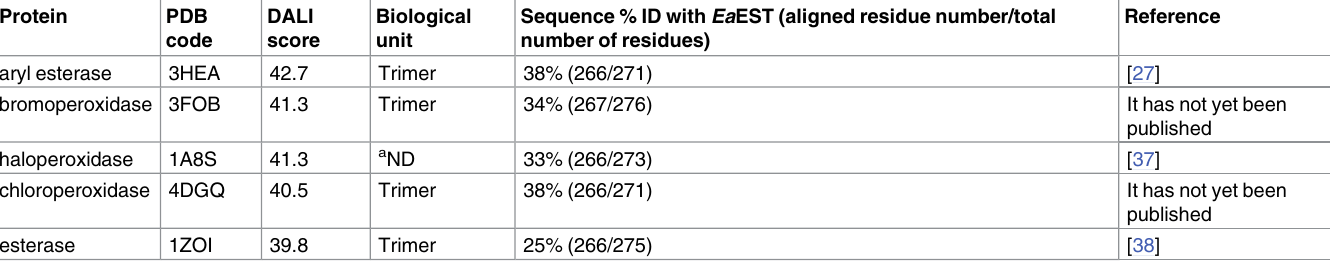
Table 2. Selected structural homologs of Ea EST obtained using DALI search (DALI-Lite server).